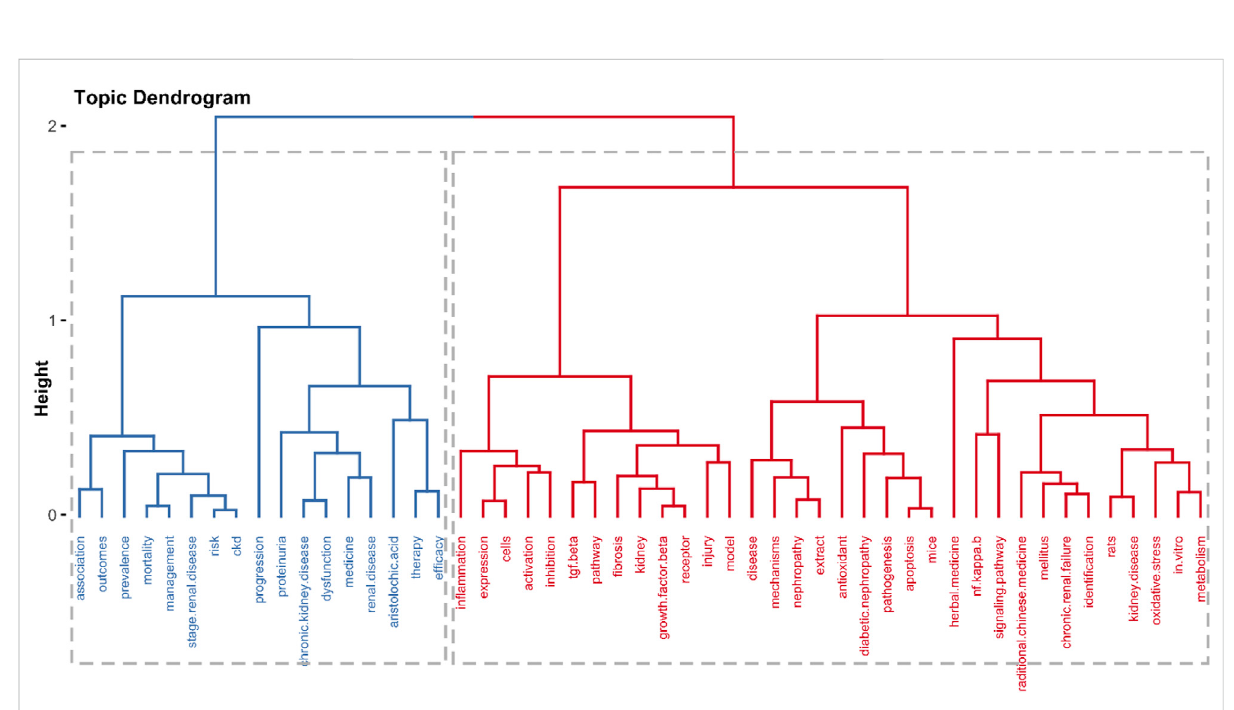
FIGURE 8 Tree dendrogram of hierarchical cluster analysis of keywords in the fi eld of herbal medicine treatment for CKD.